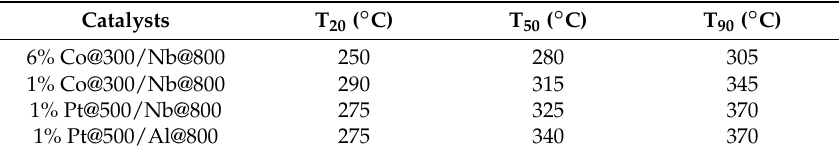
Table 5. T 20 , T 50 , and T 90 of fresh Co catalysts and Pt catalysts for propane oxidation. Catalysts T 20 ( ◦